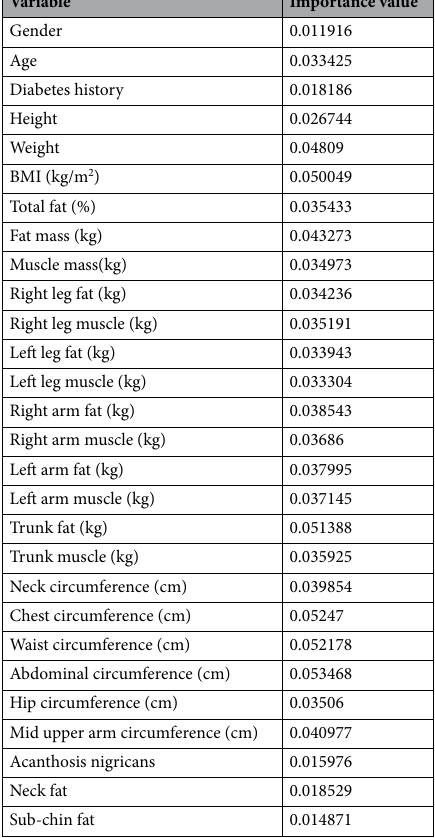
Table 5. Variable Importance from the random forest method for steatosis